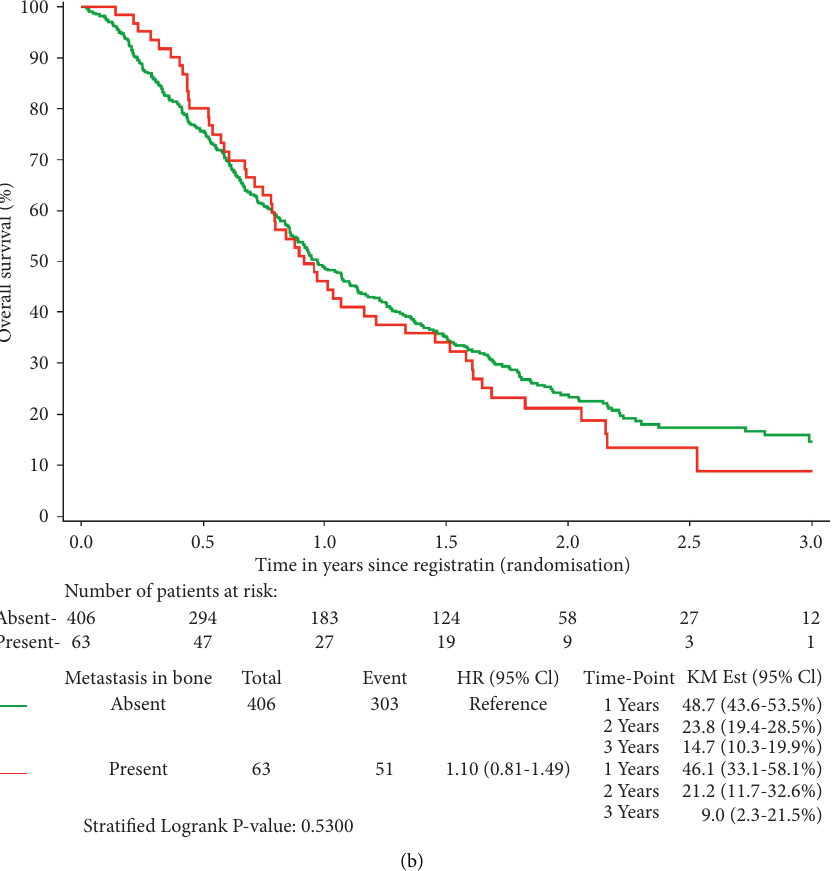
Figure 2: Kaplan–Meier curves for the effect of bone metastasis on OS stratified by study: (a) first line and (b) second line or higher population. Table 3: Cox model for the adjusted effect of bone metastasis on OS per line of treatment stratified by study.